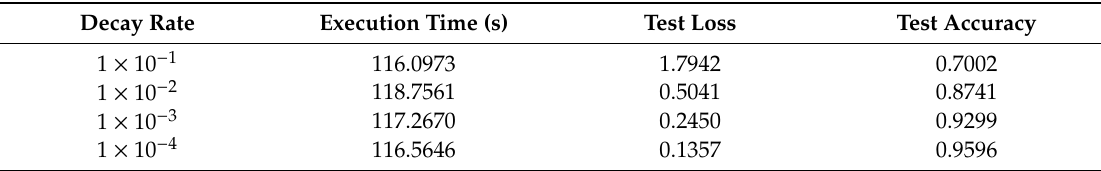
Table 18. E ff ect of learning rate decay on multilayer perceptron.